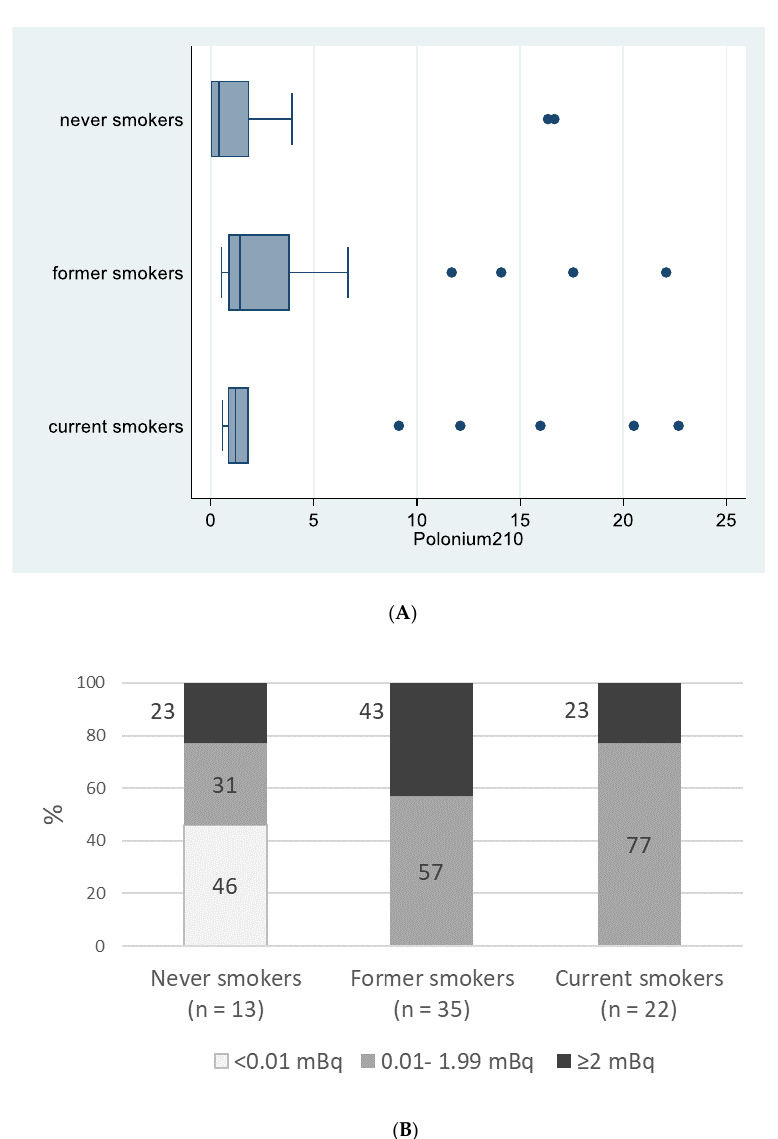
Figure 1. Polonium-210 (in mBq) by smoking status, “Polonium in vivo” study ( n = 70). ( A ) Box plot of polonium-210 (in mBq) by smoking status. The left and right borders of the box are the lower and upper quartiles; the solid line in the box is the median. The “whiskers”, that is, the lower and upper adjacent values, are used for identifying extreme values in the tails of the distribution. Dots greater than the upper adjacent value, represent outliers. ( B ) Polonium-210 levels (<0.01 mBq; 0.01–1.99 mBq; >=2 mBq) by smoking status. As shown in Figure 2, levels of 210 Po were higher among COPD patients compared to patients with no COPD (median value: 3.60 vs. 0.97 mBq; p = 0.007; Table 2).